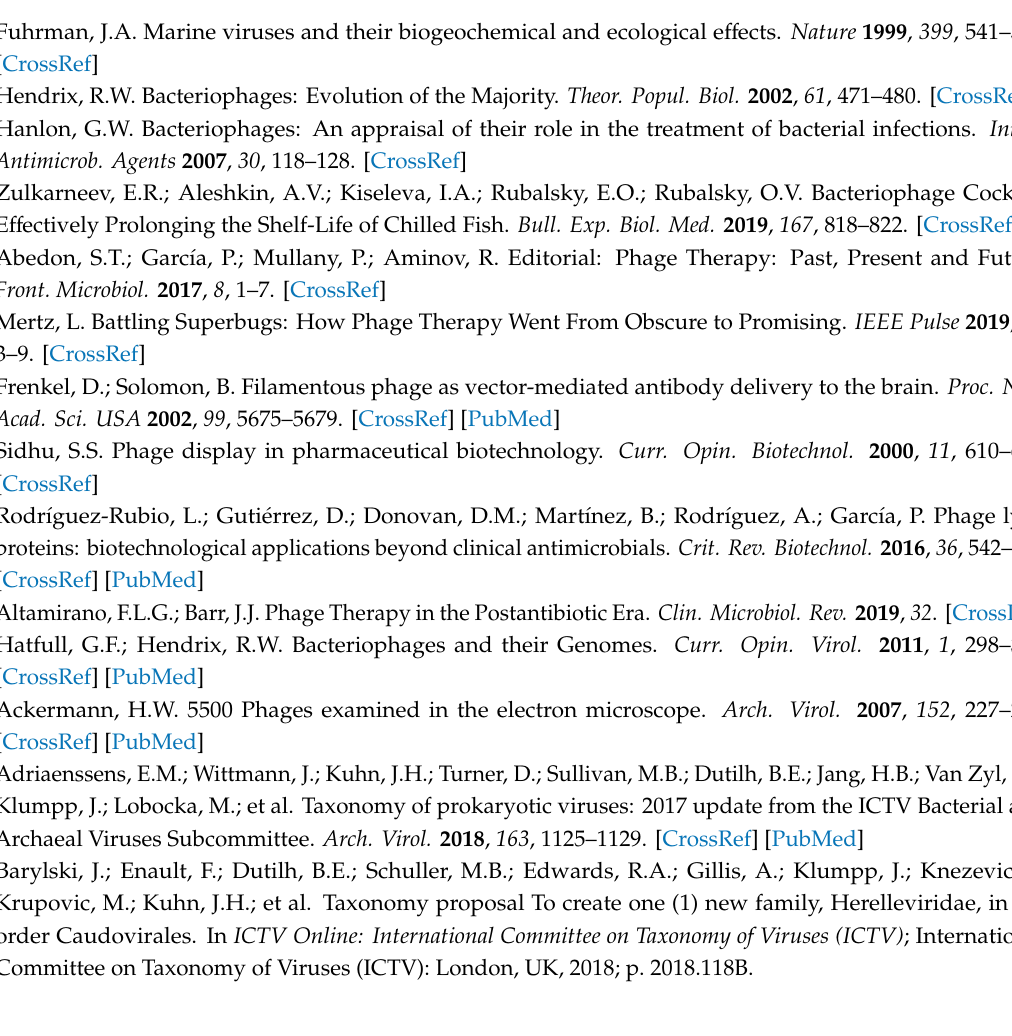
Figure S1: pH and temperature stability of vB_StuS_MMDA13, Figure S2: Proteomic phylogenetic tree of vB_StuS_MMDA13 and related phages, Table S1: General features of the coding regions of the vB_StuS_MMDA13